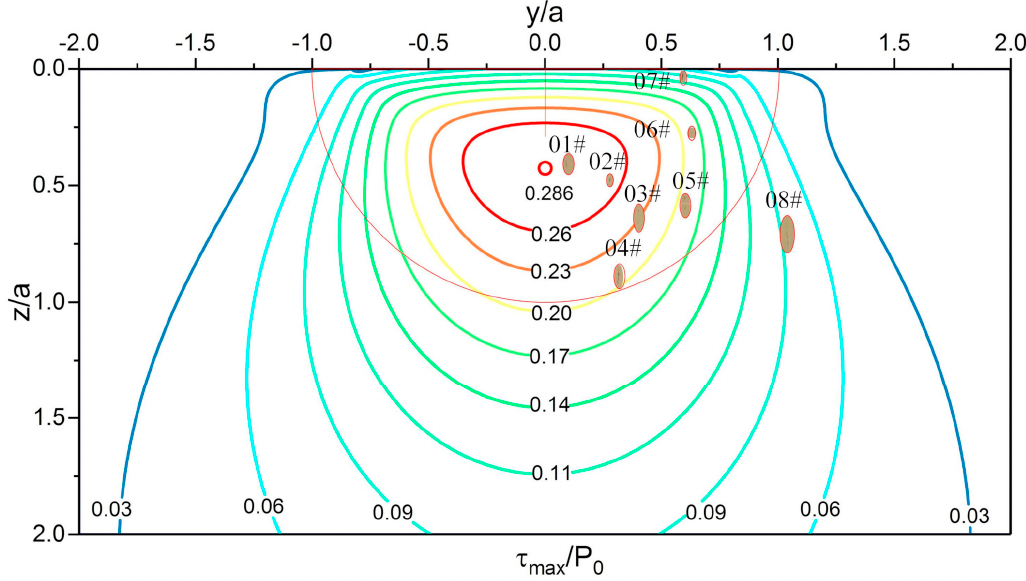
Figure 10. Composite image of inclusion positions and principal shear stress ( τ max ) field in 0.3 mm section of the plate specimen. Drawing of stress contours is based on Fu’s thesis [10]. For a point inside the material, y/a is the ratio of the horizontal distance (from the point to the contact center) to the contact radius, and z/a is the ratio of the depth to the contact radius.